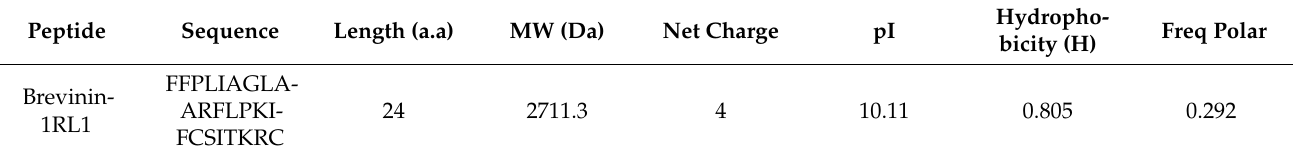
Table 1. Amino acid sequence, length, molecular weight and related biological parameters of Brevinin-1RL1. Peptide